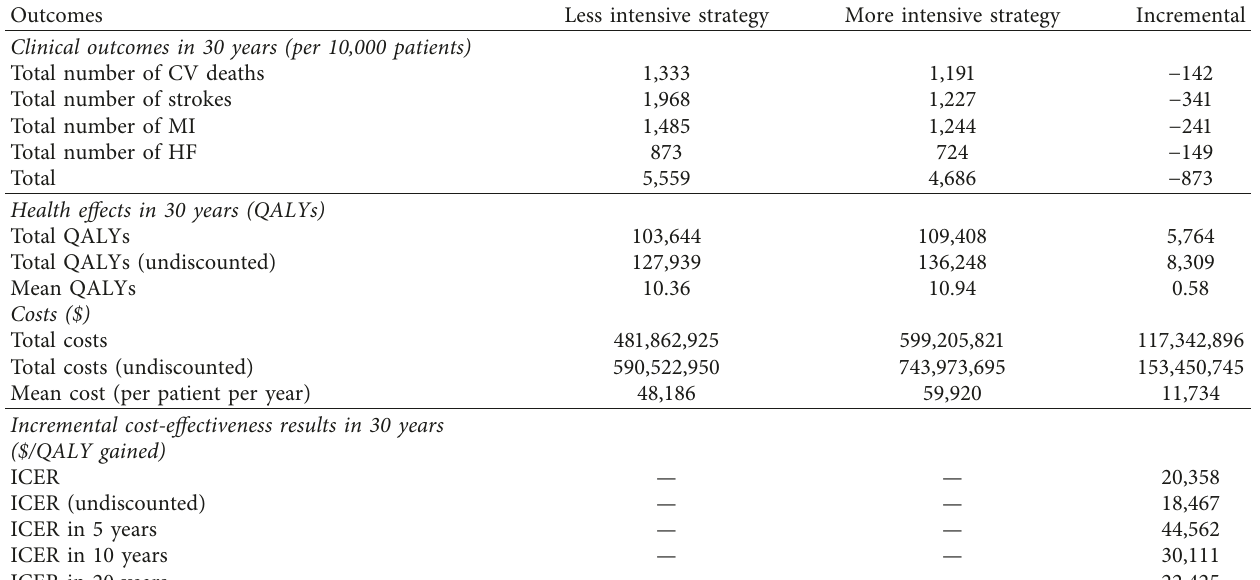
Table 2: Projected health outcomes, costs, and QALY of more intensive vs. less intensive BP strategy.